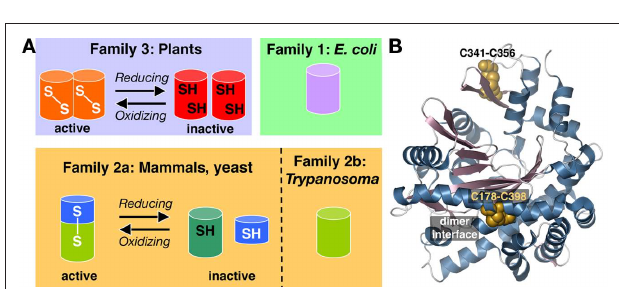
Figure 3 | Overview of glutamate–cysteine ligase. (A) Oligomeric organization and redox regulation of the three types of GCL are shown. (B) Structure of the B. juncea GCL showing the positions of the two disulfide bonds (gold space-filling models). Secondary structure elements are colored as follows: α -helices in blue and β -strands in rose.